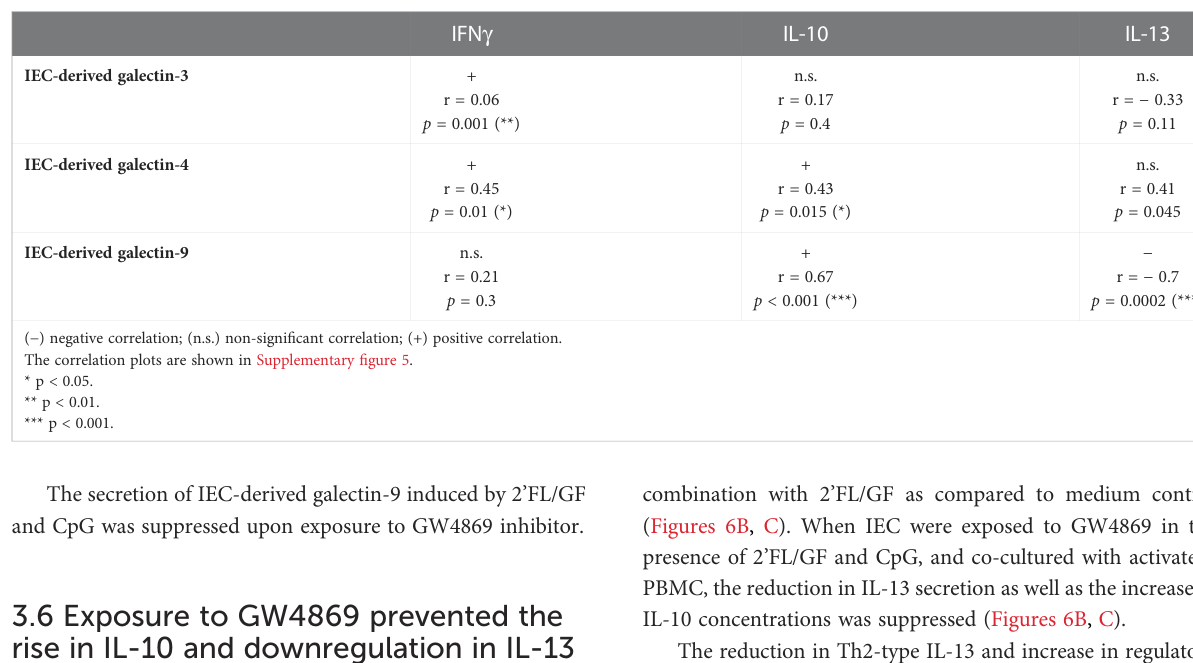
TABLE 1 Correlations between cytokines in the IEC/PBMC co-culture and epithelial-derived galectins.